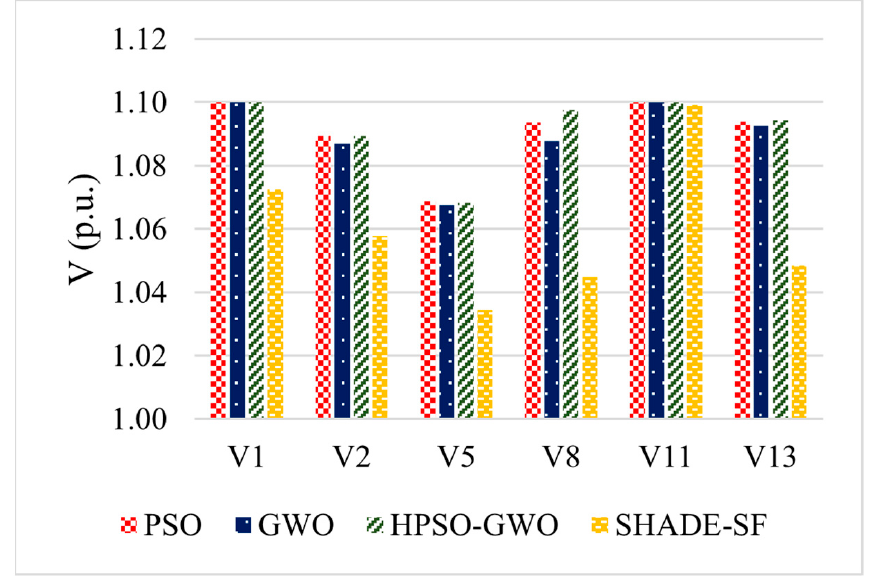
Figure 14. Generator bus voltages comparison (Case